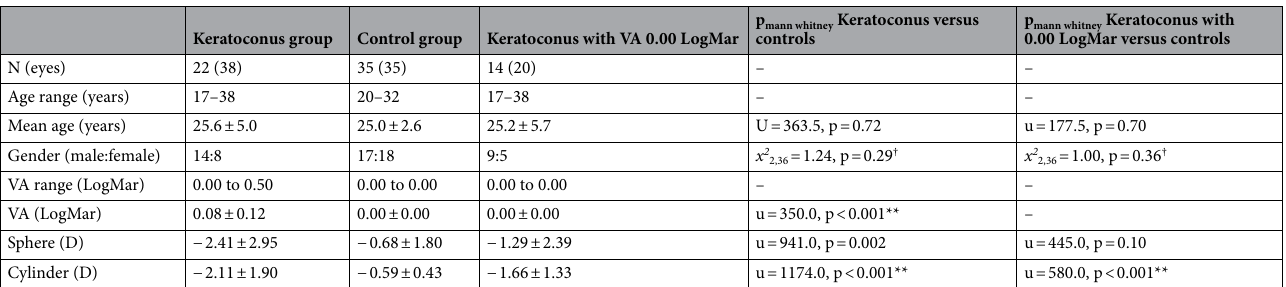
Table 1. Demography, mean visual acuity and refraction for keratoconus group, keratoconus subjects with visual acuity of 0.00 LogMar and for control group. *Significant level of < 0.05, **Significant level of < 0.005. † Fisher’s exact test was done to test the gender differences between groups. VA, visual acuity; D,